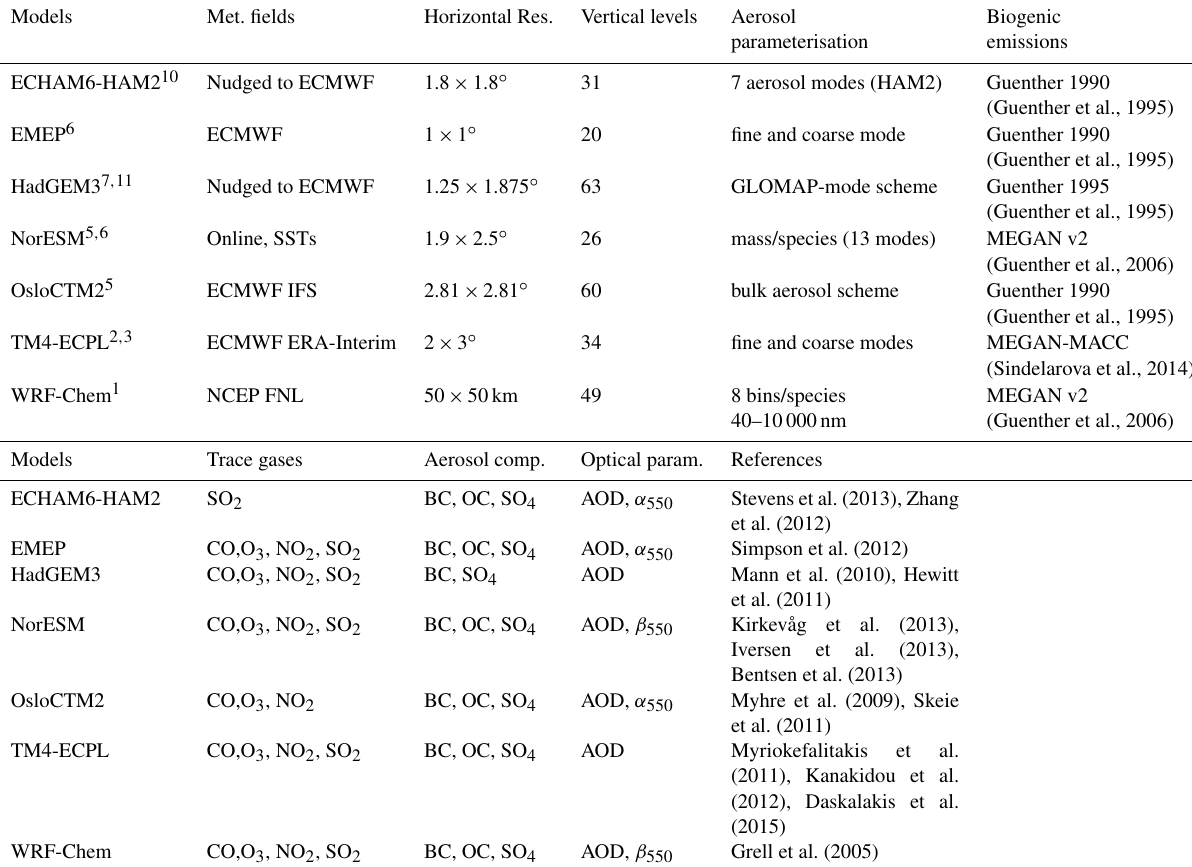
Table 1. ECLIPSE model descriptions including meteorological fields used to nudge simulations (where applicable), spatial resolution, aerosol schemes and biogenic emissions. Trace gases, aerosol species and optical parameters output by the models are provided together with references for the different models. Institutes responsible for each model are indicated with the indices of the author